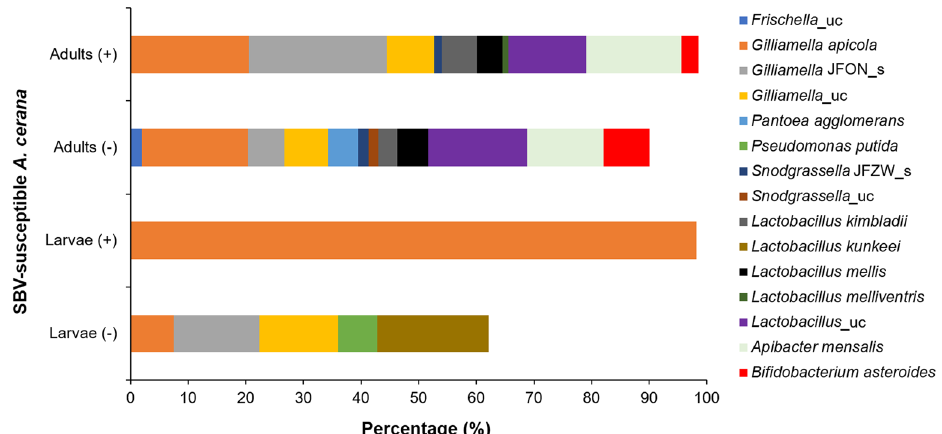
Figure 1. Gut microbiome of SBV-susceptible Apis cerana . Bacterial species were identified from the gut of sacbrood virus (SBV)-susceptible A. cerana adults and larvae from both healthy (−) and sacbrood disease (SD)- affected (+) honey bees collected from Cheongju province. (“uc” indicates unclassified species; “JFON_s” and “JFZW_s” indicate uncultured species of genera Gilliamella and Snodgrassella ,